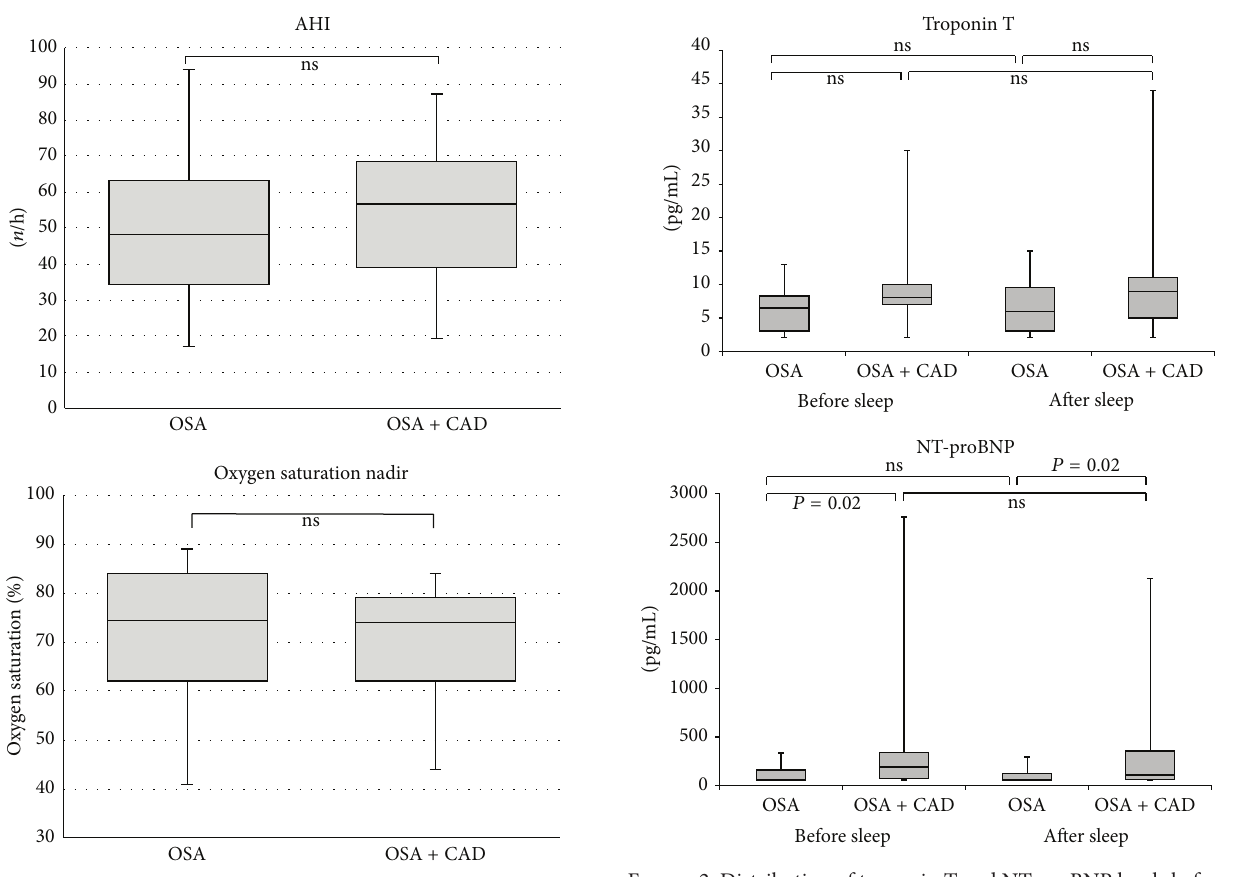
Figure 1: Comparison of polysomnography data (AHI: apnea- hypopnea-index; CAD: coronary artery disease; OSA: obstructive sleep apnea). Middle horizontal line inside box indicates median. Bottom and top of the box are 25th and 75th percentiles, and the error bars outside the box represent maximum and minimum values, respectively.